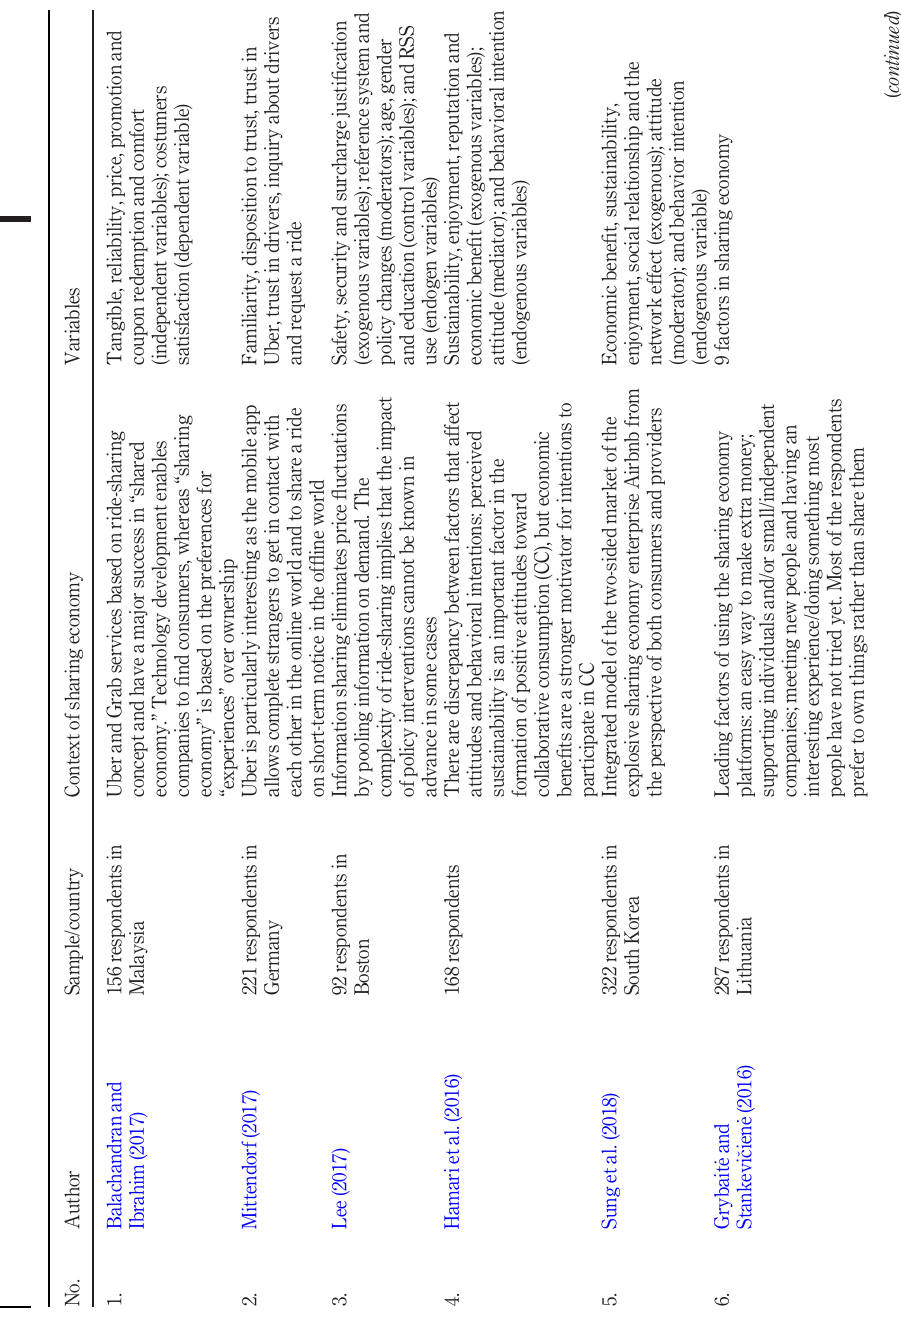
Table I. Previous research about sharing